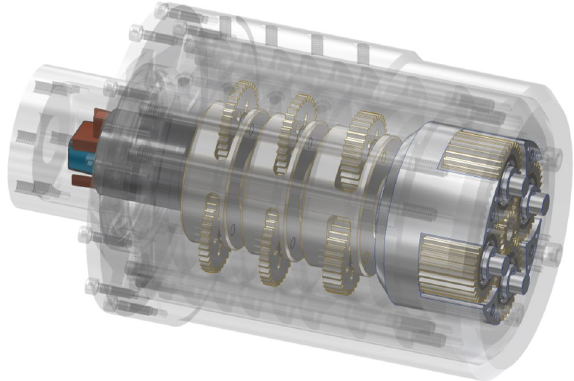
Figure 3. View of the interior of the transmission.